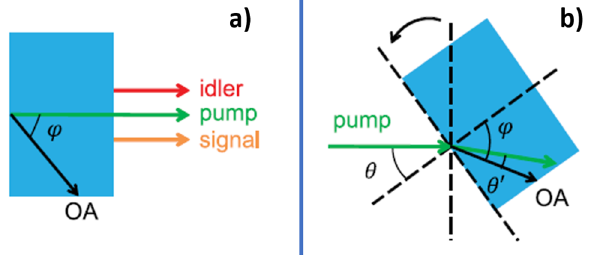
Figure 13. ( a ) Pump beam normally incident to the crystal surface ( b ) Pump beam incident to the rotated crystal. ϕ is the cut angle; θ is the angle between the pump direction and the crystal surface. Reproduced with permission from [60], copyright 2021.